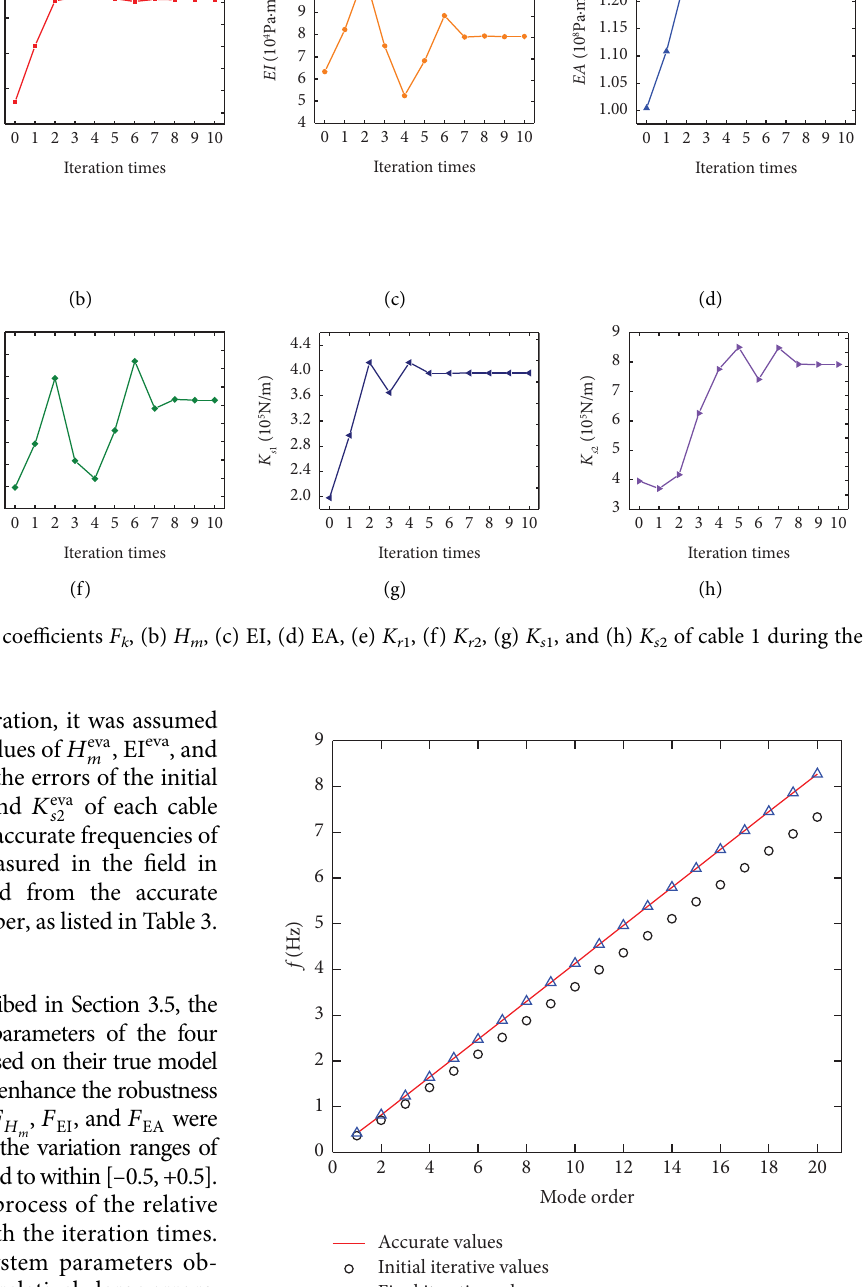
Figure 11: Comparison of iteration results with accurate values of modal frequencies of cable